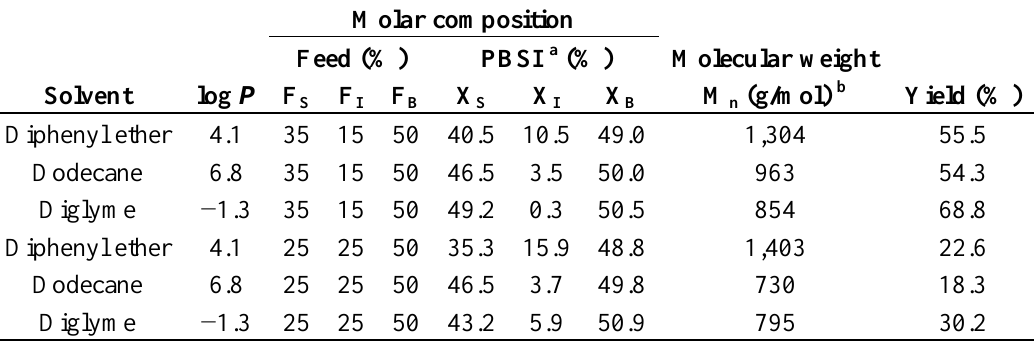
Table 1. The effect of solvent on CALB-catalyzed synthesis of poly(butylene succinate- co - itaconate)